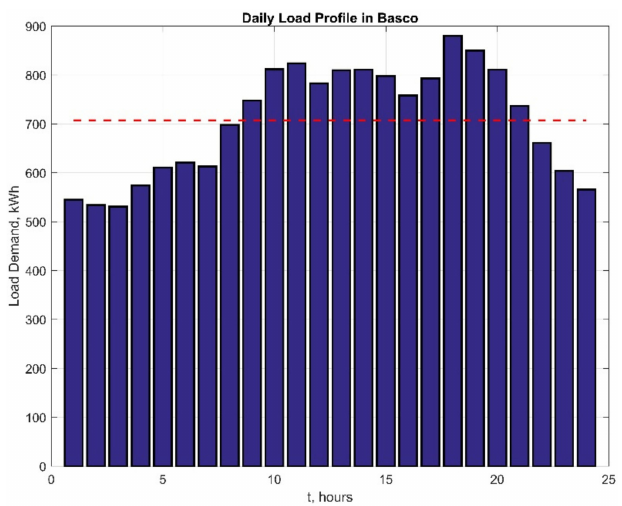
Figure 8. The typical daily load profile in Basco, Philippines.